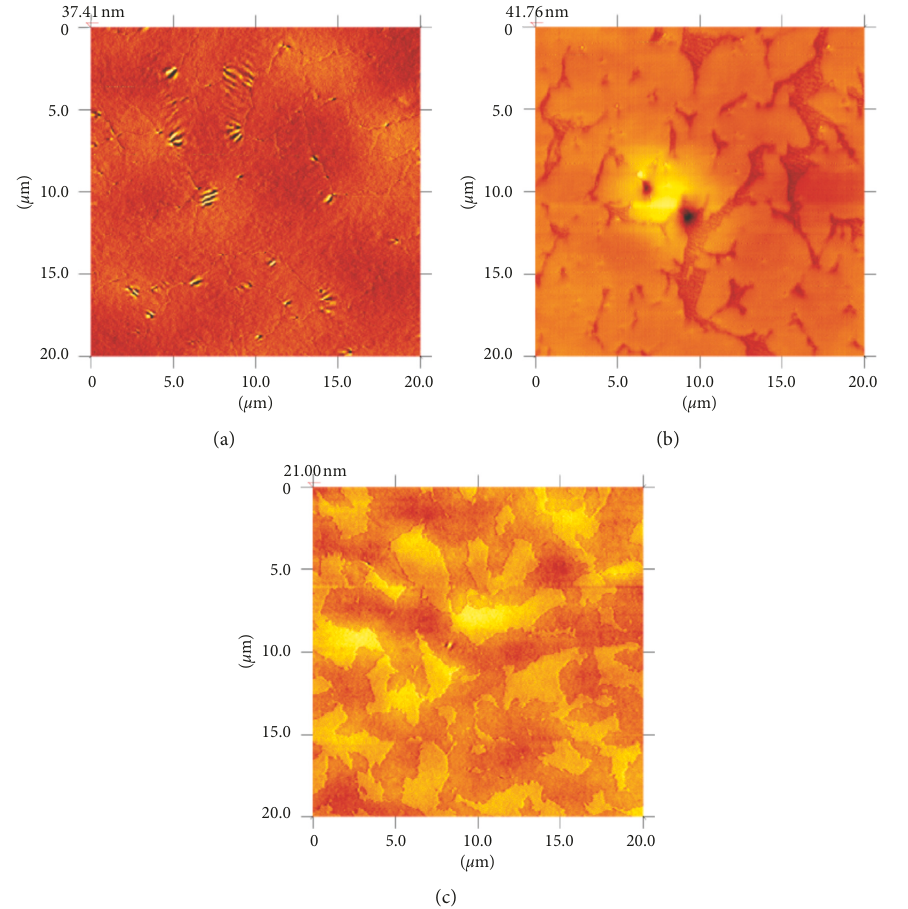
Figure 5: Images of asphalt morphology (AAK-1 sample, size 20 μ m × 20 μ m) of film thickness of 1600nm (a), 1000nm (b), and 600nm